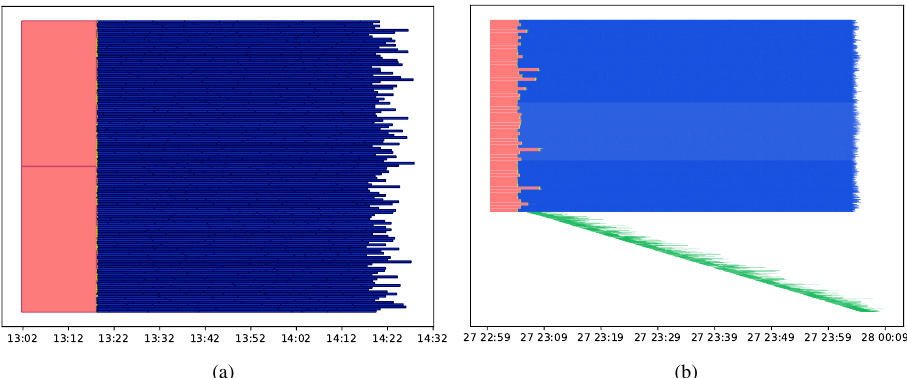
Figure 3: CPU utilization at NERSC’s Cori HPC with the Ray-based ATLAS Event Service prototype application. ATLAS Geant4 Inner Detector only simulation tasks were ran. Blue rectangles represent single events being processed– from start time to finish. Red rectan- gles are Athena initialization times and green rectangles between red and blue rectangles are initialization times of individual AthenaMP worker processes. (a) Example of a two-node ap- plication running on Cori NKL with a 64-process application on each node. (b) Example of a 60-node application running on Cori Haswell with a 32-process application on each